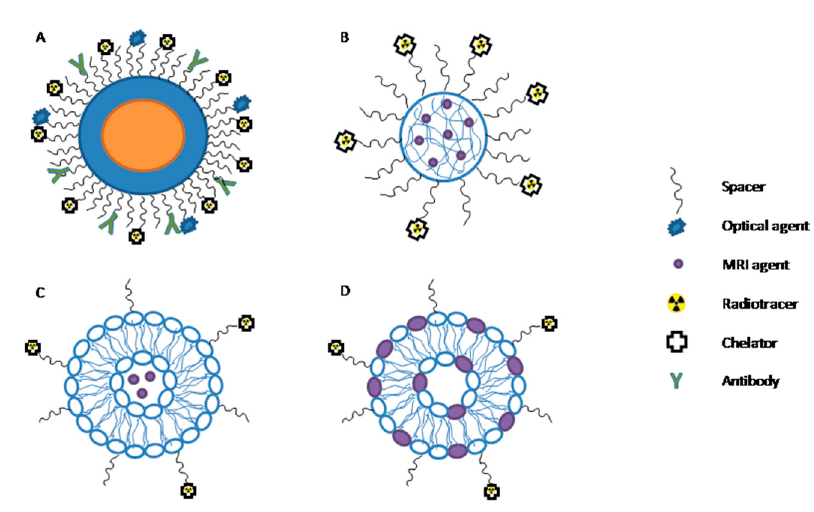
Figure 1. Multimodal nanoparticles. ( A ) Multimodal nanoparticle composed by a core (representing the magnetic resonance imaging (MRI) component) and a shell functionalized with an antibody. The positron emission tomography (PET) radiotracer is chelated and bound to the spacer. ( B ) A polymeric nanoparticle entrapping paramagnetic moieties is represented, where the PET radiotracer is chelated and bound to the spacer. ( C ) Liposomal formulation entraps paramagnetic moieties in the aqueous inner core, while the PET component is covalently linked to the spacer. ( D ) Liposomal formulation with paramagnetic ion inserted in the